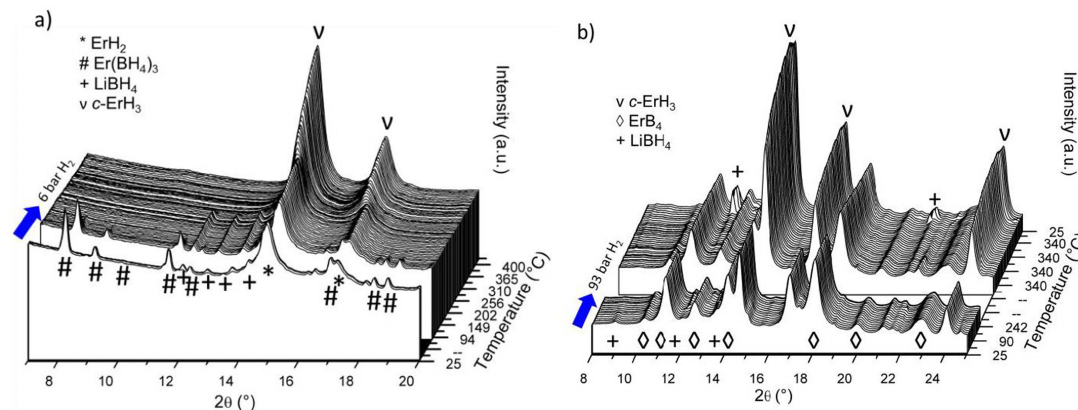
Figure 4. In situ SR-PXD data showing ( a ) desorption of S2 during heating from RT to 400 ◦ C (5 ◦ C · min − 1 ) under 6 bar H 2 . A detector connection loss is the reason for the gaps in intensity (heating continued). λ = 0.77787 Å; ( b ) reabsorption of Sieverts apparatus desorbed S2 during heating from RT to 340 ◦ C (5 ◦ C · min − 1 ) under 93 bar H 2 followed by a 2-h isotherm, and cooling to RT. λ = 0.77787 Å.